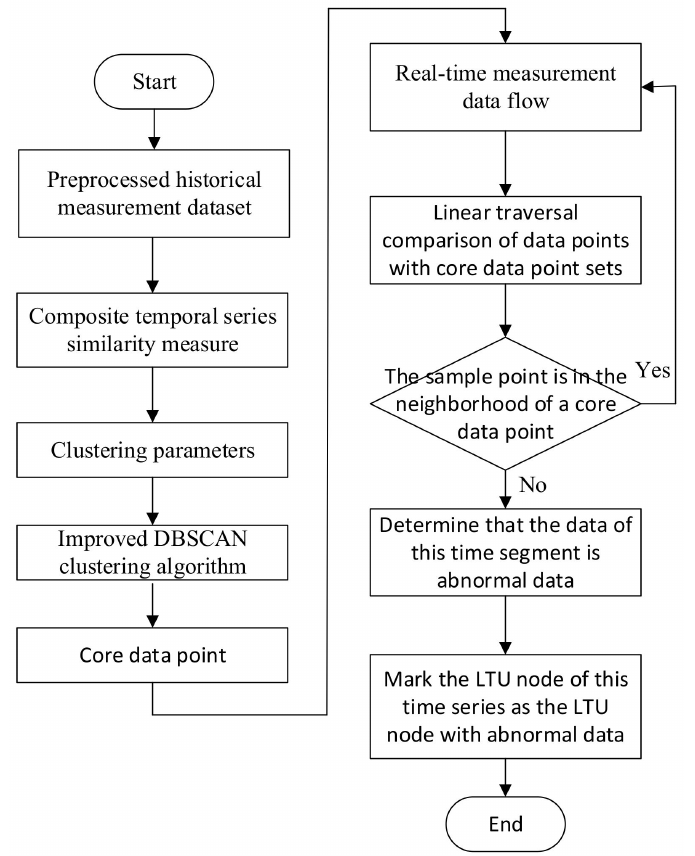
Figure 4. Anomaly detection program